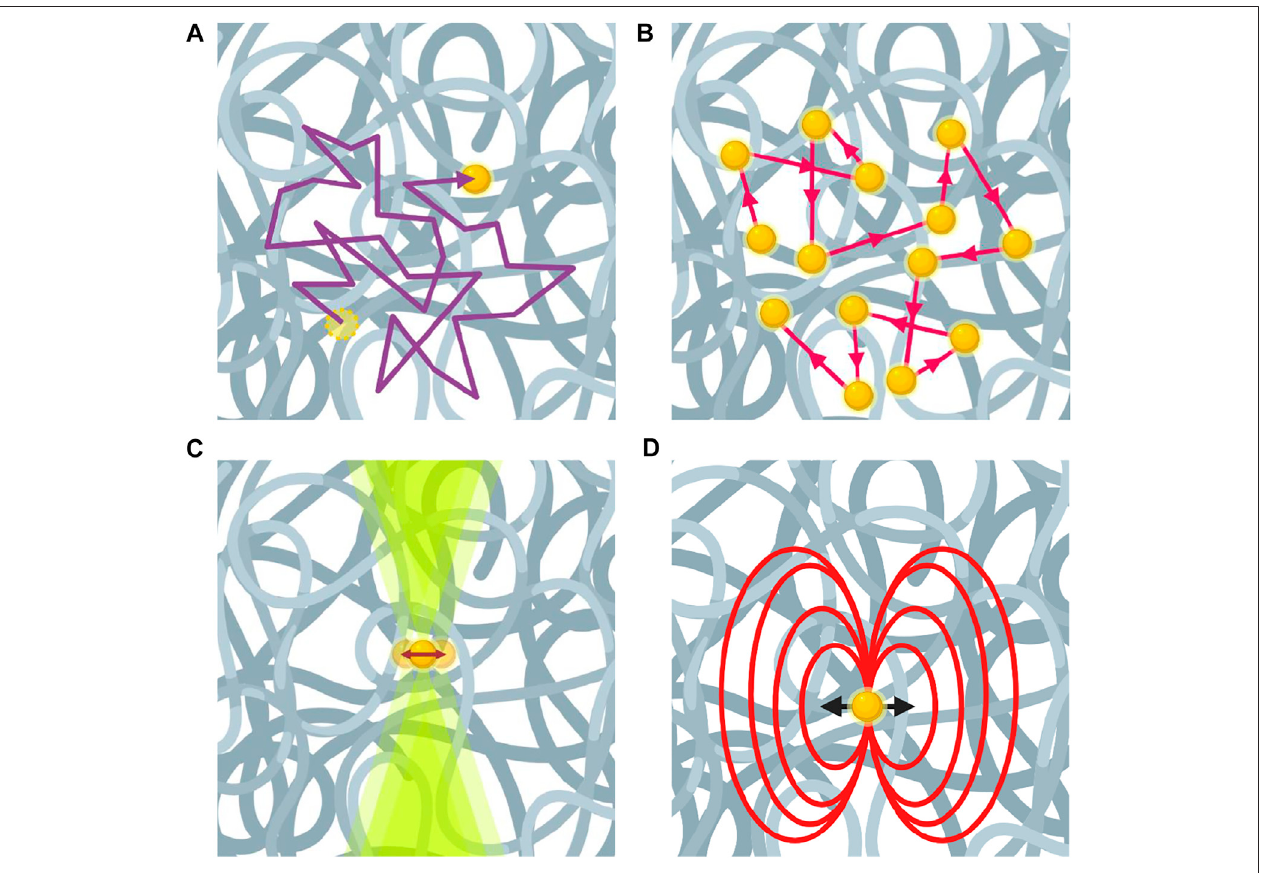
FIGURE 2 | Microrheology using different techniques for passive and active measurements. (A) Video particle tracking technique visually tracks the trajectories of probe particles. (B) Multiple-scattered laser in diffusing wave spectroscopy experiment re fl ect Brownian motion of probe particles. (C) Optical tweezers measure the force and displacement on a probe particle. (D) Magnetic fi eld exerted on a probe particle by magnetic tweezers.